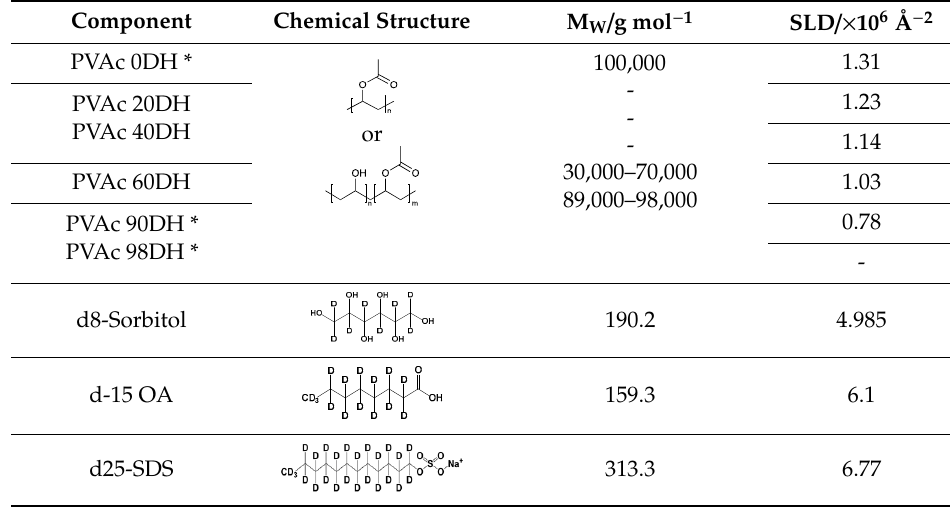
Table 1. Physicochemical characteristics of the components such as molecular weight (Mw), scattering length density (SLD), and chemical structure. Molecules with an asterisk designate commercial components. SLDs of the synthesised polymer were calculated via a statistical average of the SLDs for pure poly(vinyl acetate) (PVAc) and polyvinyl alcohol (PVA).